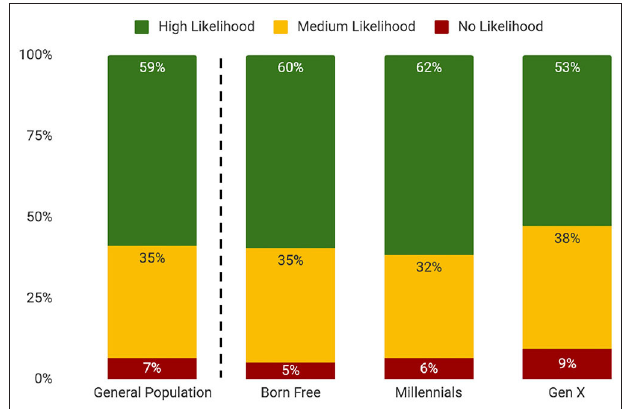
FIGURE 6 | Likelihood to purchase plant-based meat in the general population and by generations.